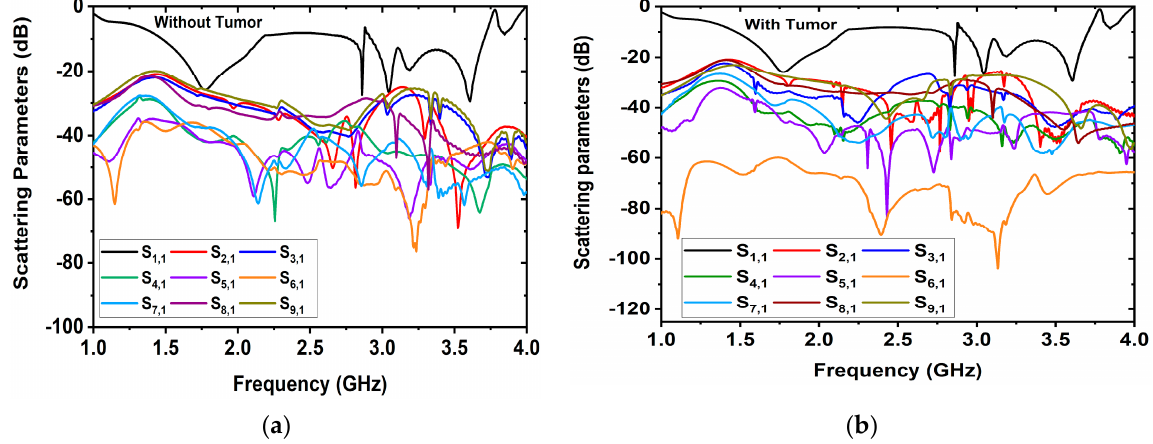
Figure 5. Experimental setup for sensors-based microwave brain imaging system [46] .